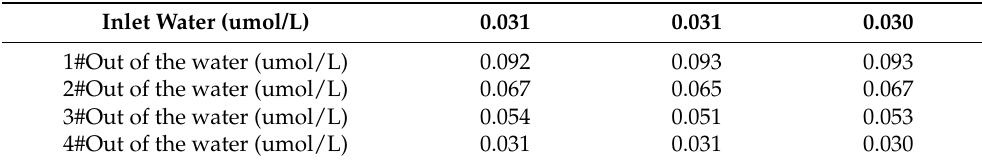
Table 5. The MDA content variation in three addition methods with Phanerochaete chrysosporium . Inlet Water